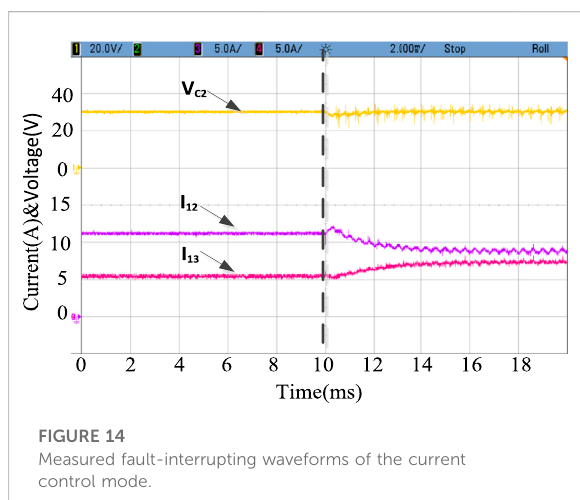
FIGURE 14 Measured fault-interrupting waveforms of the current control